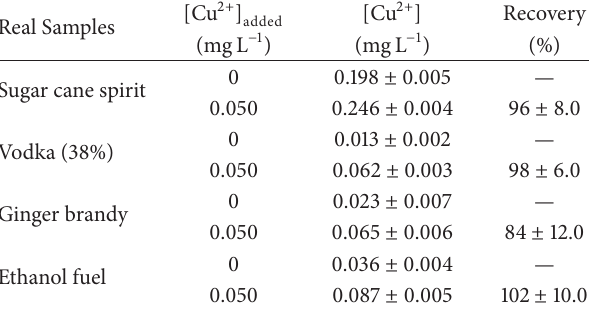
Table 5: Recovery of Cu 2+ with HCl 1.0mol L − 1 after percolation